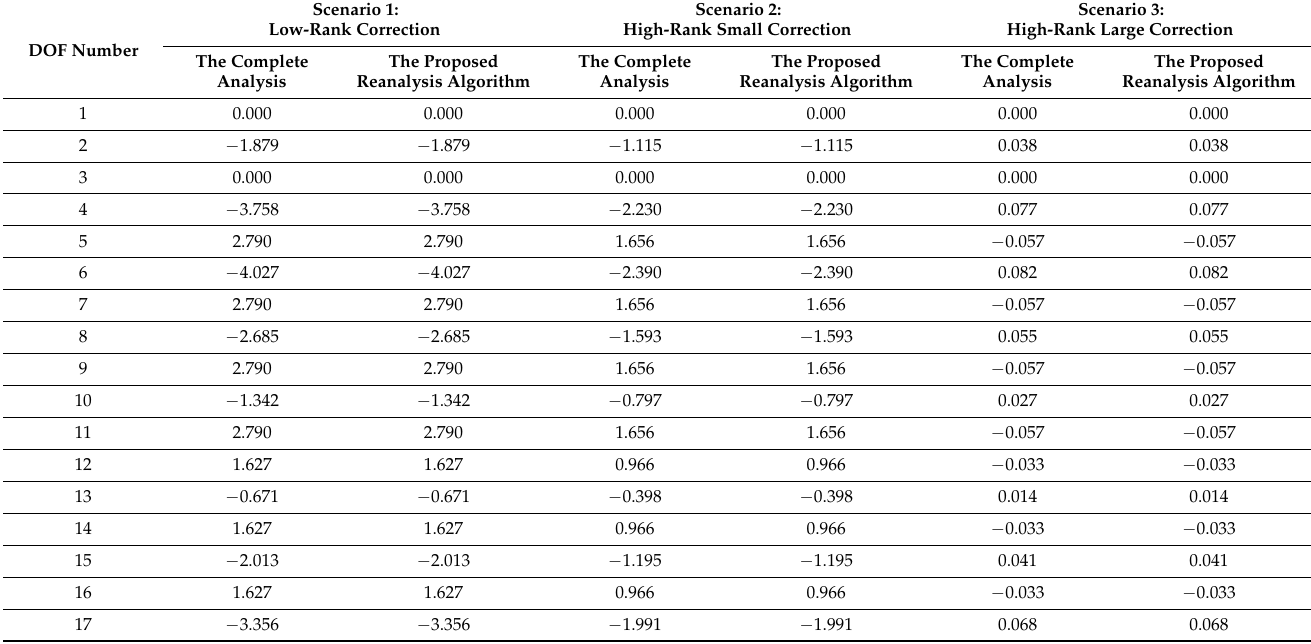
Table 3. The second-order sensitivities of displacements for modified structures ( × 10 − 3